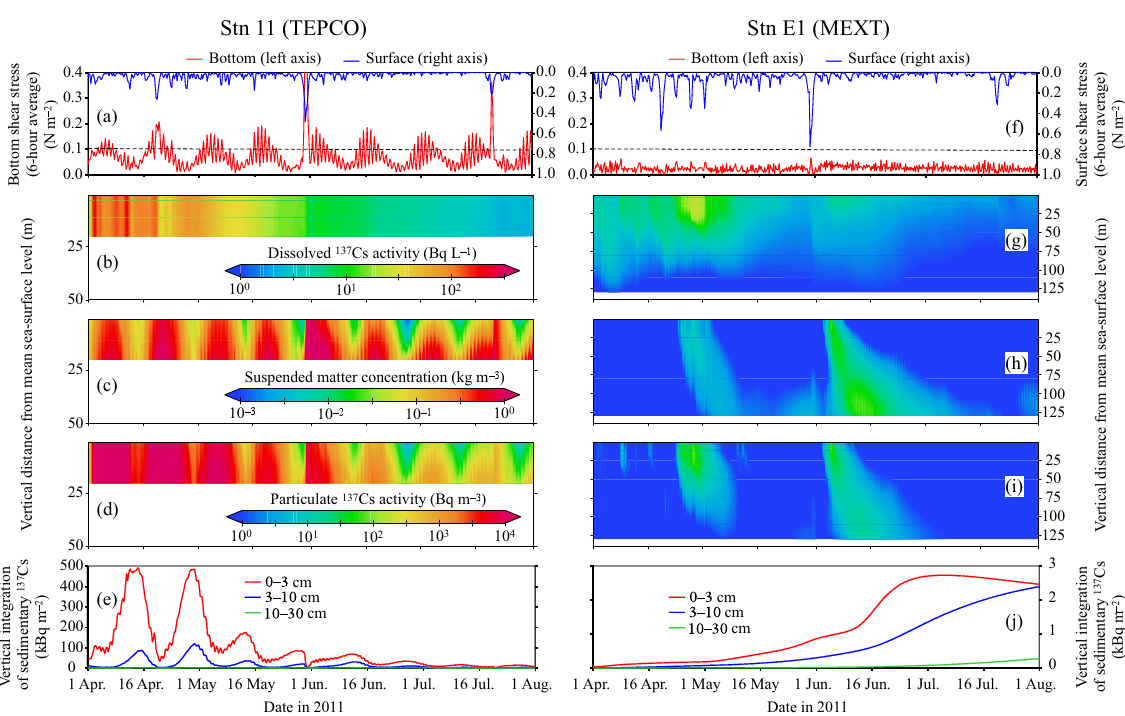
Figure 12. (a) Bottom shear stress and surface shear stress; (b–d) vertical profiles of dissolved 137 Cs activity, suspended matter concentration, and particulate 137 Cs activity in seawater respectively; (e) vertical integration of sedimentary 137 Cs at shallow site (TEPCO station 11 in Fig. 2c). (f–j) Same as (a–e) but at offshore site (MEXT station E1 in Fig.